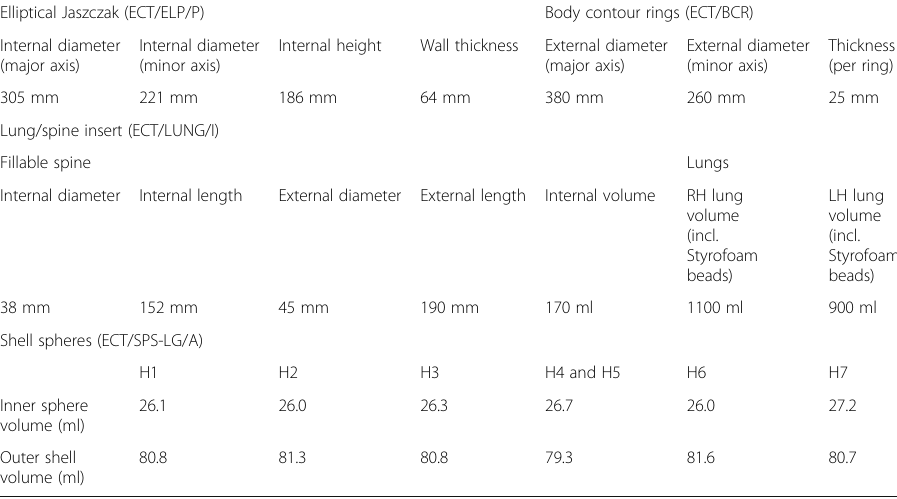
Table 1 Comparison phantom component specifications Elliptical Jaszczak (ECT/ELP/P) Body contour rings